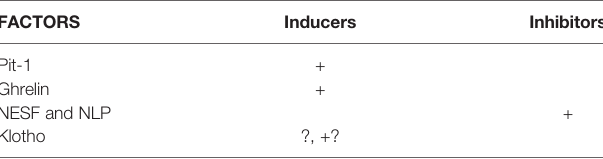
TABLE 4 | Growth Hormone transcription